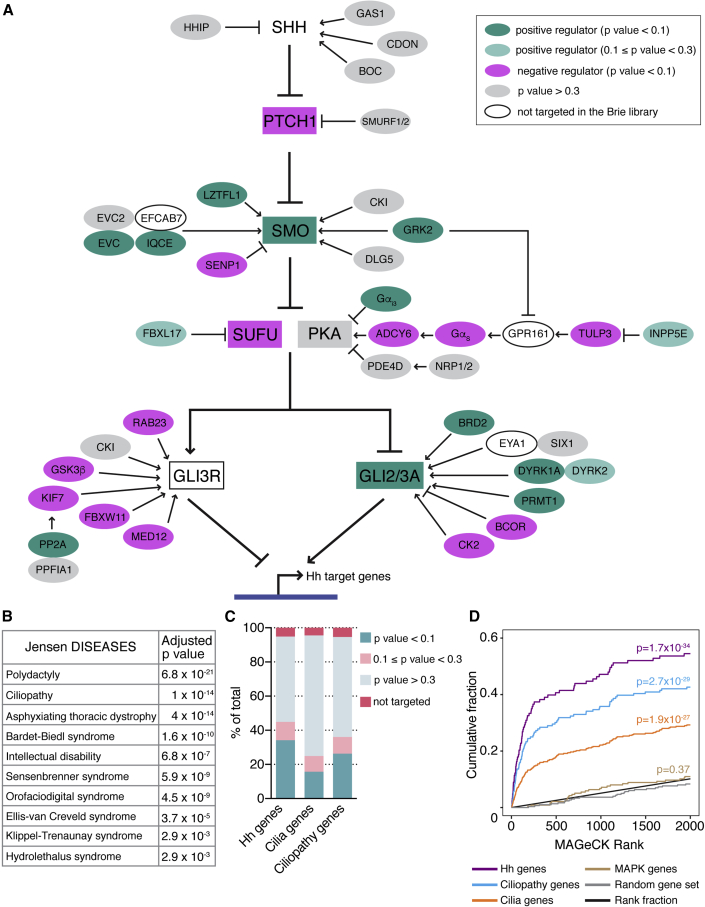
Statistically Significant Screen Hits Are Enriched in Known Hh and Cilia Genes(A) Depiction of core (rectangle) and accessory (oval) Hh pathway components, colored according to the FDR-corrected p value for their enrichment in the selected cell populations.(B) Results of enrichment analysis showing the most significant associations between hits from all screens (with an FDR-corrected p value <0.1) in the Jensen database of disease-gene associations (Pletscher-Frankild et al., 2015).(C) Fractional enrichment of known Hh, cilia, and ciliopathy genes in all screens.(D) Cumulative distribution function of HiSHH_Bot10% screen ranks for 123 Hh genes, 407 cilia genes, 176 ciliopathy genes, and two control gene lists (237 MAPK genes from the KEGG database and a random set of 300 genes). Statistical significance was calculated based on the top 2,000 genes using the hypergeometric test. See also Table S2.